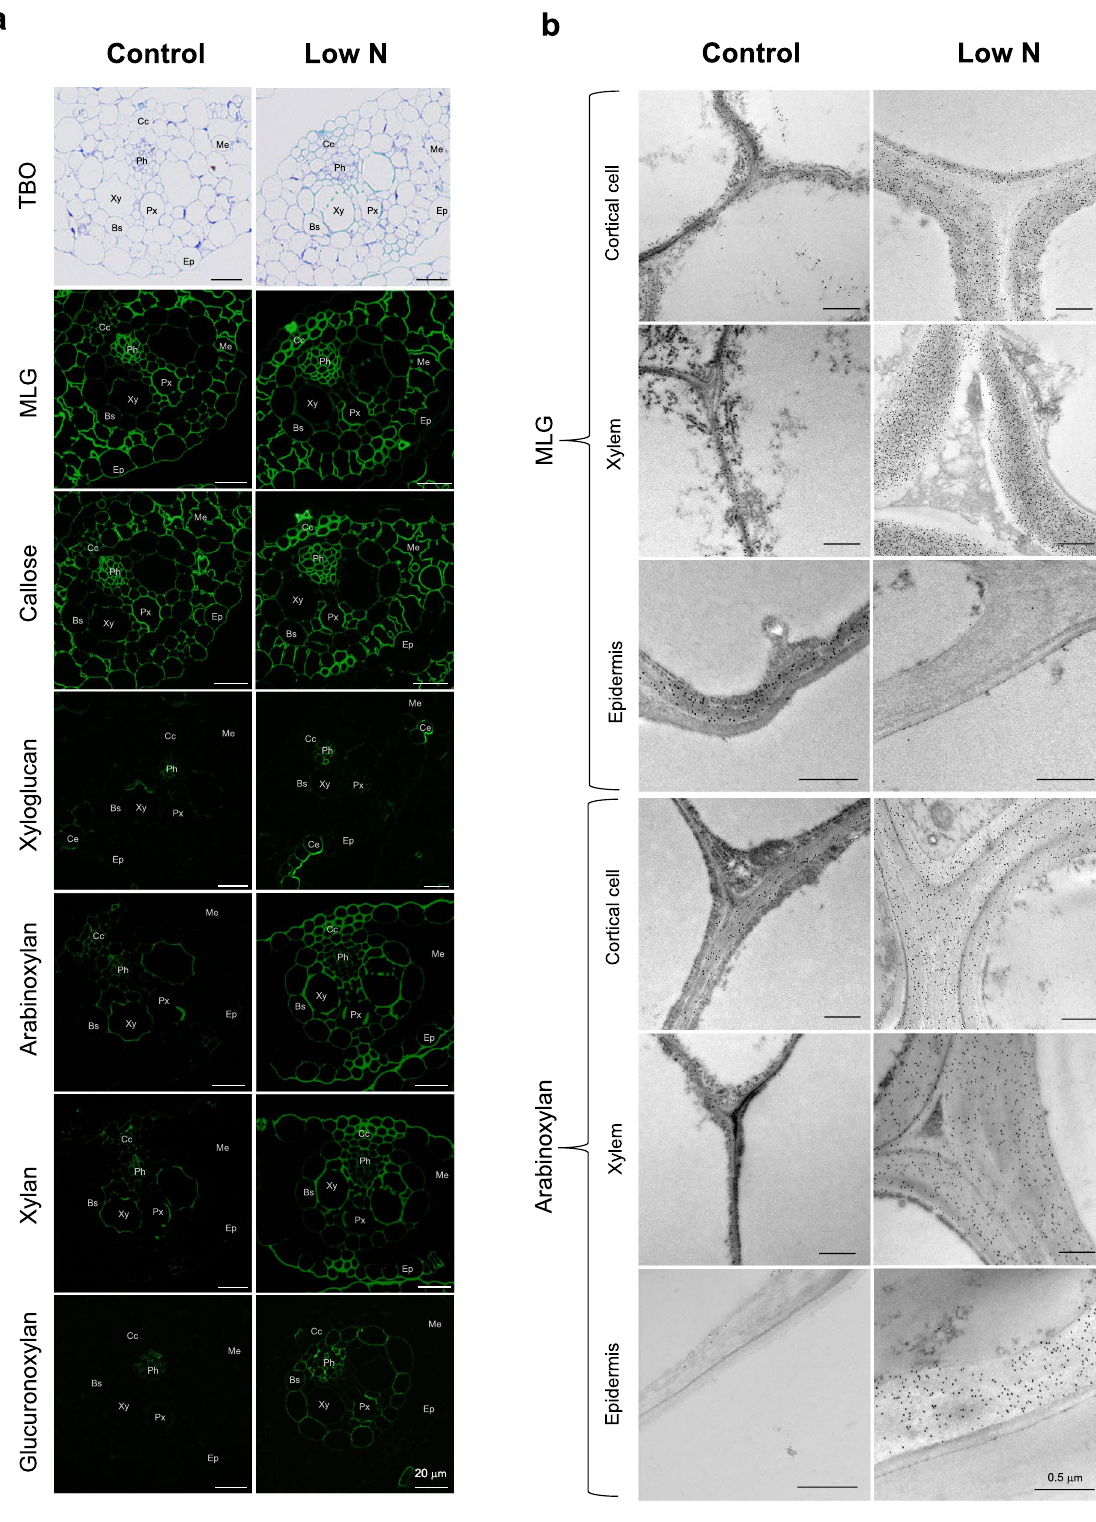
Figure 5. Immunohistochemical analyses of hydroponically-grown sorghum seedlings cultivated under control or low-N conditions at 3 weeks after treatment. ( a ) Toluidine blue O (TBO) staining and immunofluorescent labeling using anti-mixed-linkage (1 → 3), (1 → 4)-β-d-glucan (MLG), (1 → 3)-β-d-glucan (callose), xyloglucan, arabinoxylan, xylan, and glucuronoxylan antibodies, and ( b ) immunogold labeling using anti-MLG and arabinoxylan antibodies. Ep: epidermal tissues, Ce: curved epidermal tissues, Cc: cortical cells, Me: mesophyll tissues, Bs: bundle sheath, Xy: xylem, Px: protoxylem, Ph: